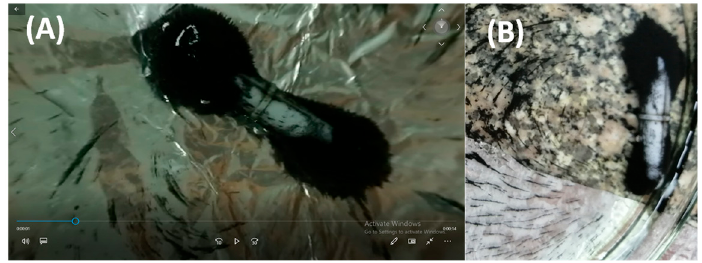
Figure 1. Photos of the prepared iron-nickel alloy during washing process ( A,B